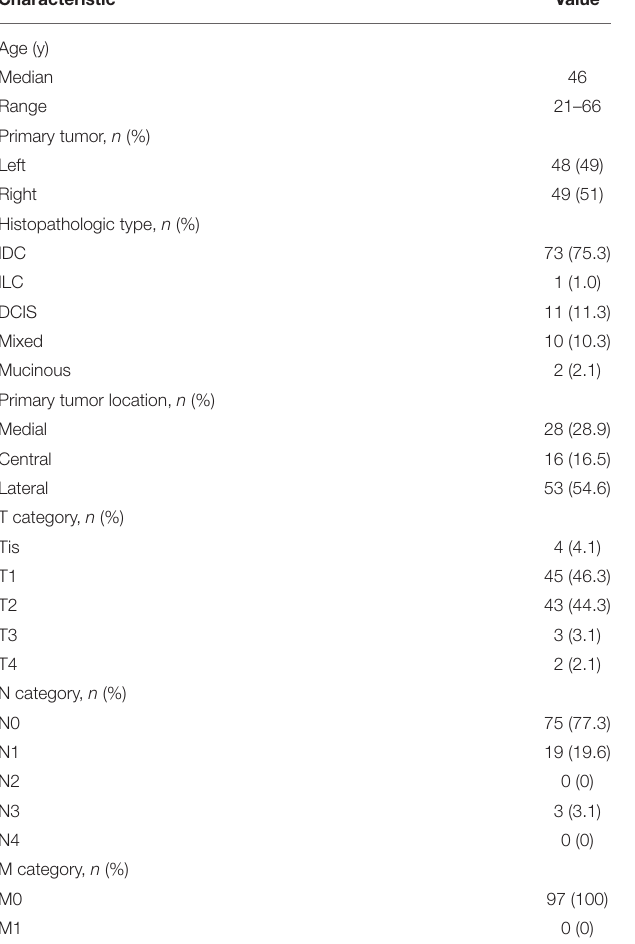
TABLE 1 | Clinical characteristics of the 97 enrolled patients.